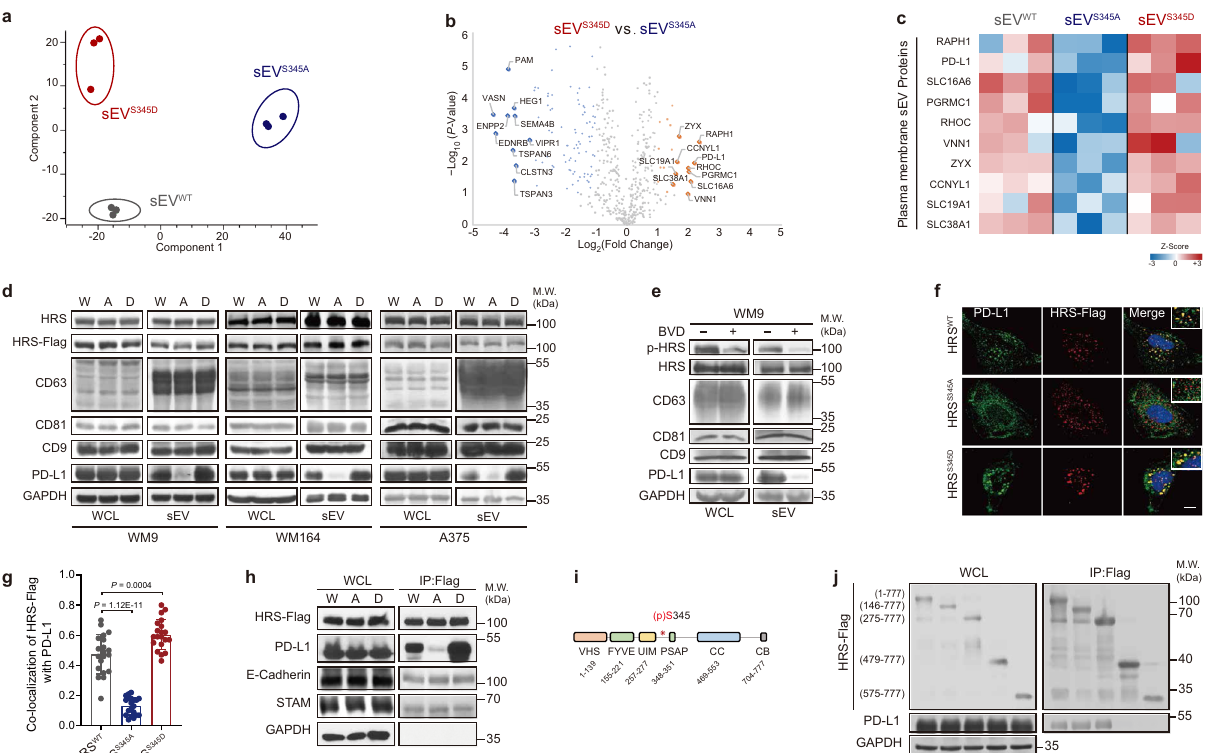
0.00.20.40.60.81.0 Fig. 3 HRS S345 phosphorylation selectively enriches PD-L1 in sEVs. a Principal component analysis (PCA) of proteomic pro fi ling of sEVs from WM9 cell lines expressing HRS WT (sEV WT ), HRS S345A (sEV S345A ) or HRS S345D (sEV S345D ). b Volcano plot displaying membrane proteins quanti fi ed by LC-MS/MS that are changed in sEVs derived from WM9 cells expressing HRS S345D compared with sEVs from cells expressing HRS S345A . Proteins were considered signi fi cantly decreased (blue) or increased (orange) based on FDR < 0.05 and fold change >2.0. The 20 proteins having the largest fold increases ( ≥ 3) or decreases ( ≤ 8) are labeled. c Heatmap showing z score intensity of sEV proteins (increased in b ) among HRS WT and mutants. d The levels of HRS, PD-L1, and other exosome proteins (CD63, CD81, and CD9) in the cell lysate ( “ WCL ” ) or sEVs puri fi ed from WM9, WM164, or A375 expressing HRS WT -Flag ( “ W ” ), HRS S345A -Flag ( “ A ” ) and HRS S345D -Flag ( “ D ” ) were determined by western blot. The same amounts of proteins were loaded. GAPDH was used as a control. e Indicated proteins in whole-cell lysates or sEVs from WM9 cells treated with vehicle or BVD-523 (2 μ M) were determined by western blot. f Immuno fl uorescence staining of PD-L1 (green) and HRS variants (red) in WM9 cells. Nuclei were stained with DAPI. Scale bar: 10 µ m. g Percentages of co-localization of endogenous PD-L1 with different HRS variants. 20 fi elds of each group were measured. h Immunoprecipitation was performed in WM9 cells expressing Flag-tagged HRS WT , HRS S345A , or HRS S345D using an anti-Flag antibody. Proteins in whole-cell lysate or precipitates (IP: Flag) were determined by western blot. GAPDH was used as loading control. i Diagram of domains of HRS. HRS binds the ubiquitinated cargo via the ubiquitin- interacting motif (UIM). The phosphorylation site S345 is located after the UIM domain. j Immunoprecipitation from cells expressing PD-L1 and Flag- tagged full-length or fragments of HRS using an anti-Flag antibody. Indicated proteins in whole-cell lysate or precipitates were determined by western blotting. GAPDH was used as loading control for cell lysates. Left panel shows the levels of proteins in cell lysates; the right panel shows the immunoprecipitated HRS fragments and bound PD-L1. Data are representative of three independent experiments ( d , e , h , j ) or are pooled from two ( a , b , c ) or four experiments ( f , g ). Data represent mean ± s.d. Statistical analyses were performed using permutation-based FDR ( b ) or one-way ANOVA ( g ). Tukey ’ s test was used following ANOVA. Source data are provided as a Source Data fi TTDEs from tumors expressing HRS S345A ( “ TTDE S345A ” ) had a